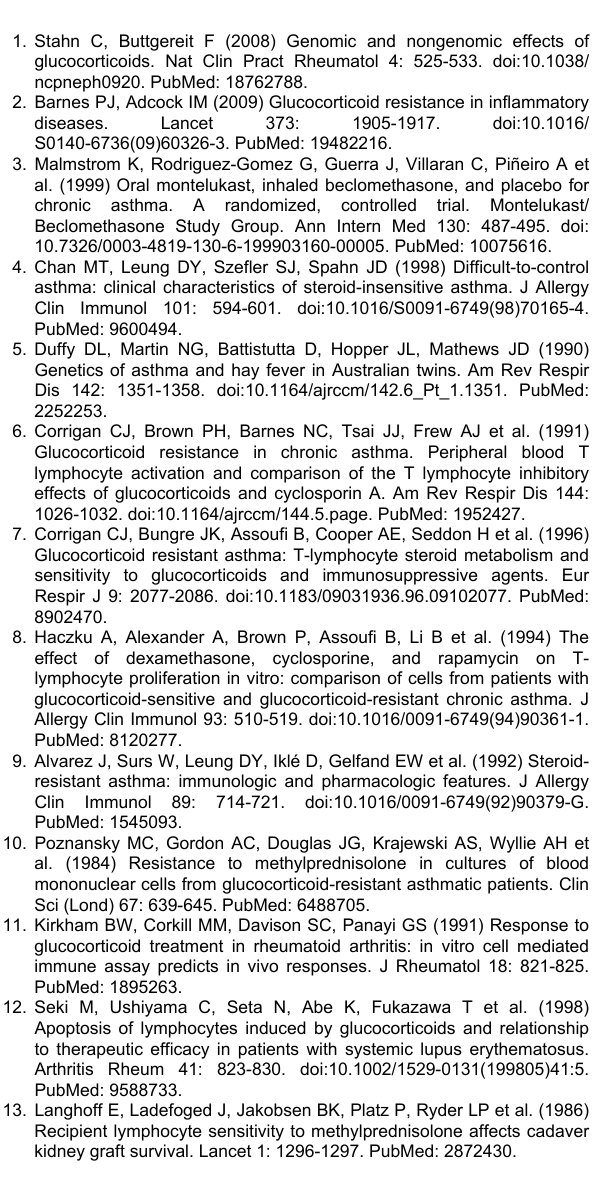
Table S6. Network analysis of downregulated genes only in response to dexamethasone treatment at 24 hours.